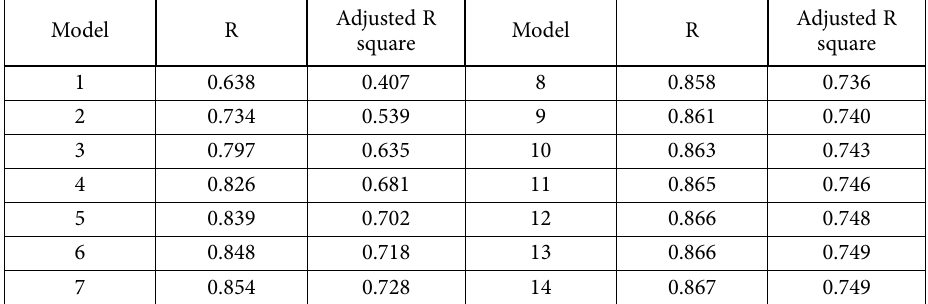
Table 10. Model summary